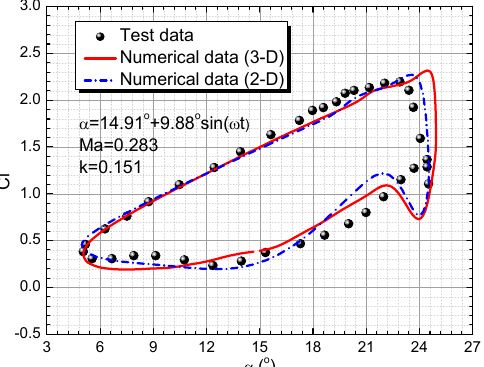
Figure 2. Comparison of numerical C l with test data.